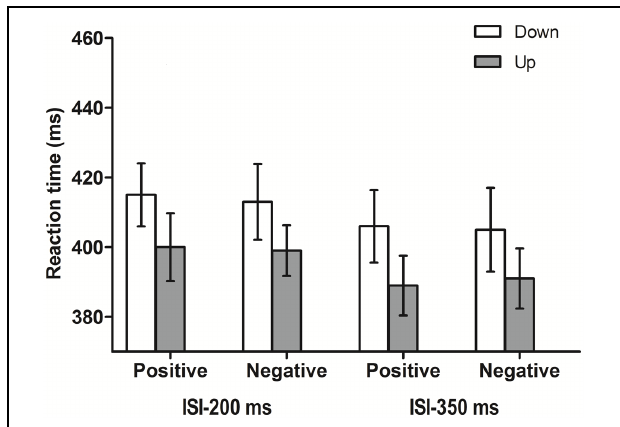
FIGURE 2 | Means of the median reaction times (ms) for all the conditions in Experiment 1. Error bars represent 95% CIs adjusted for within-subjects designs (Cousineau,